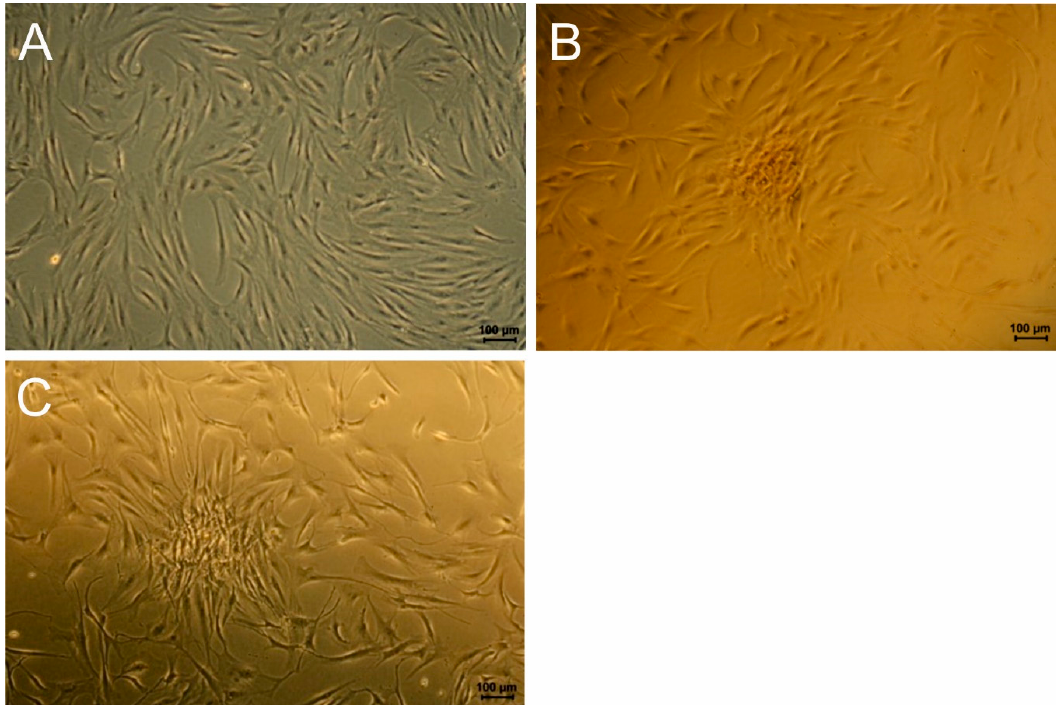
Figure 6. Examples of light microscopy images of Alizarin red stained BMSCs grown on ( A ) reference (Donor 409 46), ( B ) FeDip50 (Donor 46), and ( C ) FeDip50 (Donor 54) at day 5.